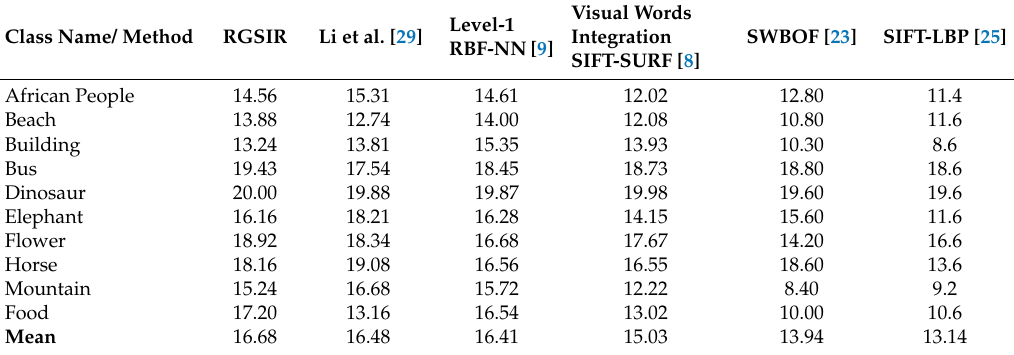
Table 2. Comparison of recall when using Corel-1K image dataset.